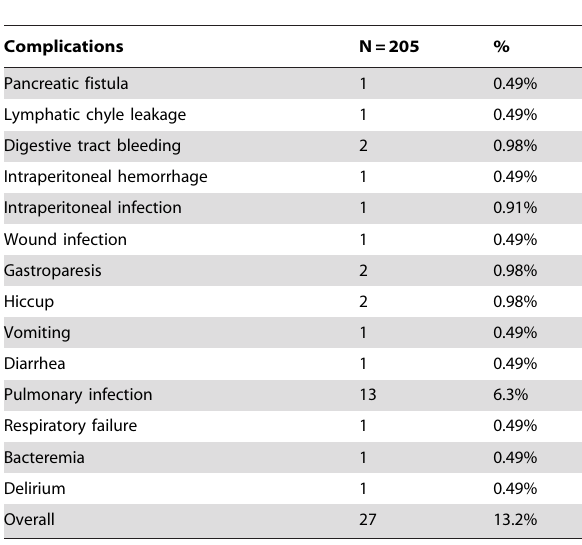
Table 4. Details of postoperative